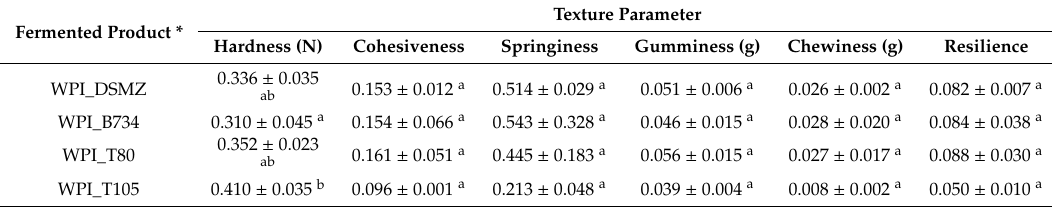
Table 1. Comparison of the texture parameters of the fermented milk